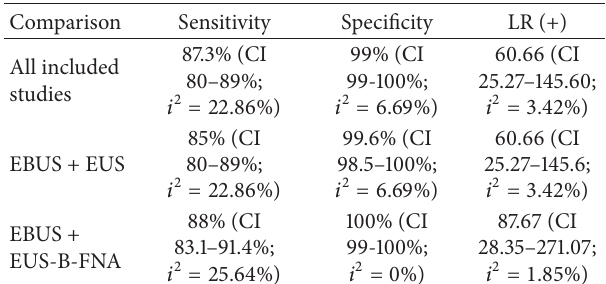
Table 3: Summary of meta-analysis of all included studies and subgroup